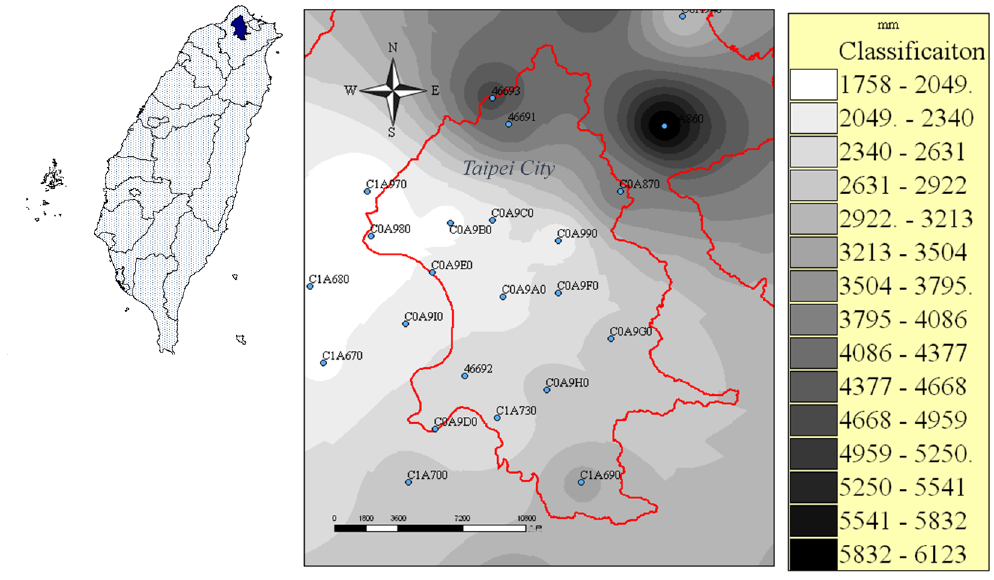
Figure 2. Average annual rainfall and the locations of rainfall